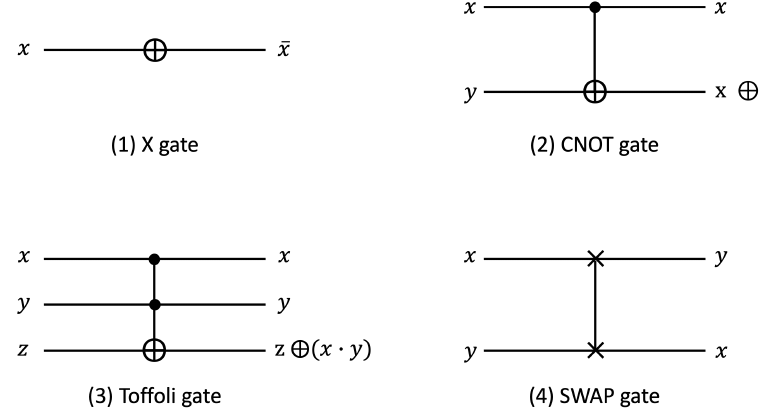
Figure 3. Quantum gates: X gate, CNOT gate, Toffoli gate, and SWAP gate.